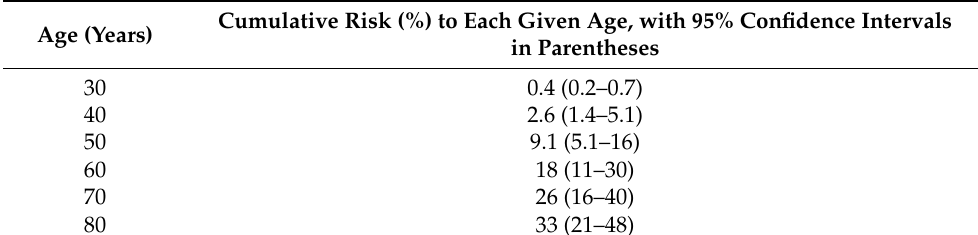
Table 2. Average age-specific cumulative risk (penetrance) of breast cancer to various ages, for female, Australian carriers of pathogenic and likely pathogenic CHEK2 variants (combined).